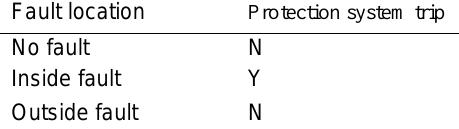
Figure 8. The SEL 387E trip signal response: the green line represents the line current and the black line is the trip